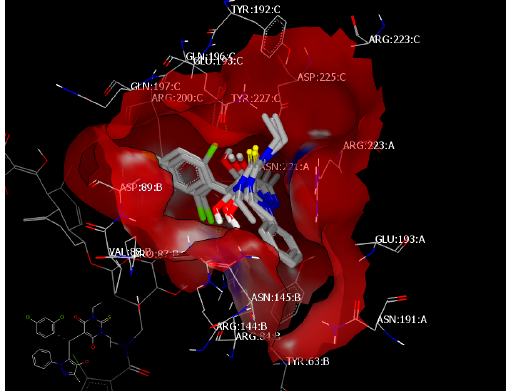
Figure 9. Visual representation of compounds 4l and 4m docked with 4URM without HB interaction and overlay with 4b .